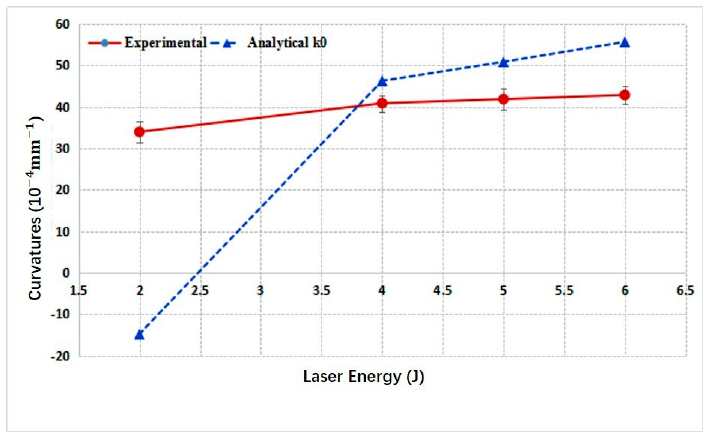
Figure 9. Curvatures of 1 mm 2024 aluminum alloy vs. laser pulse energies.